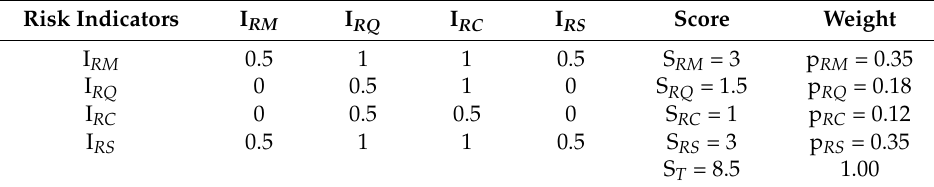
Table 12. Environmental performance risk indicators.